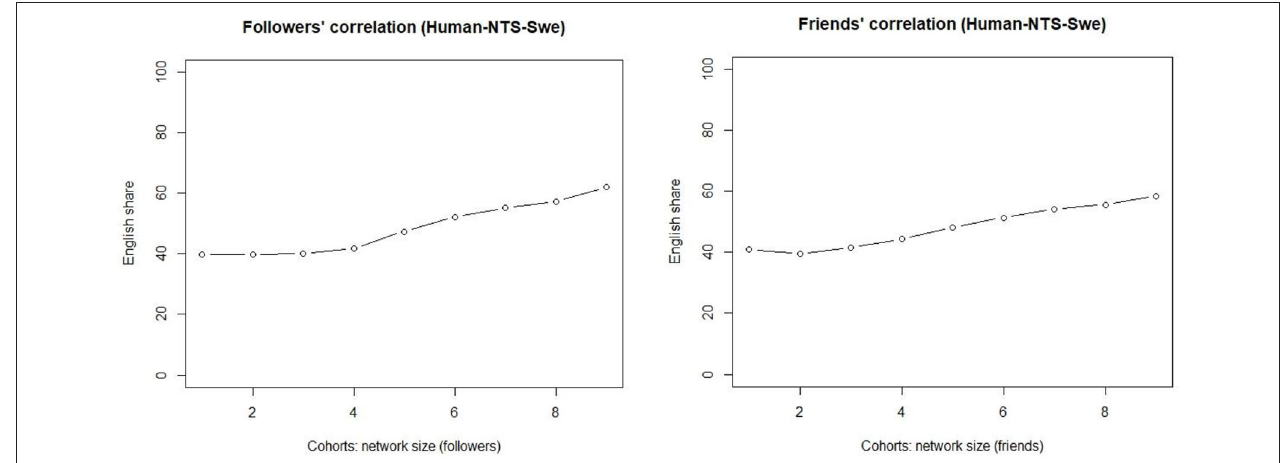
FIGURE 5 | Bot-free correlations of truly weak ties ( Left ) and slightly stronger ties ( Right ).